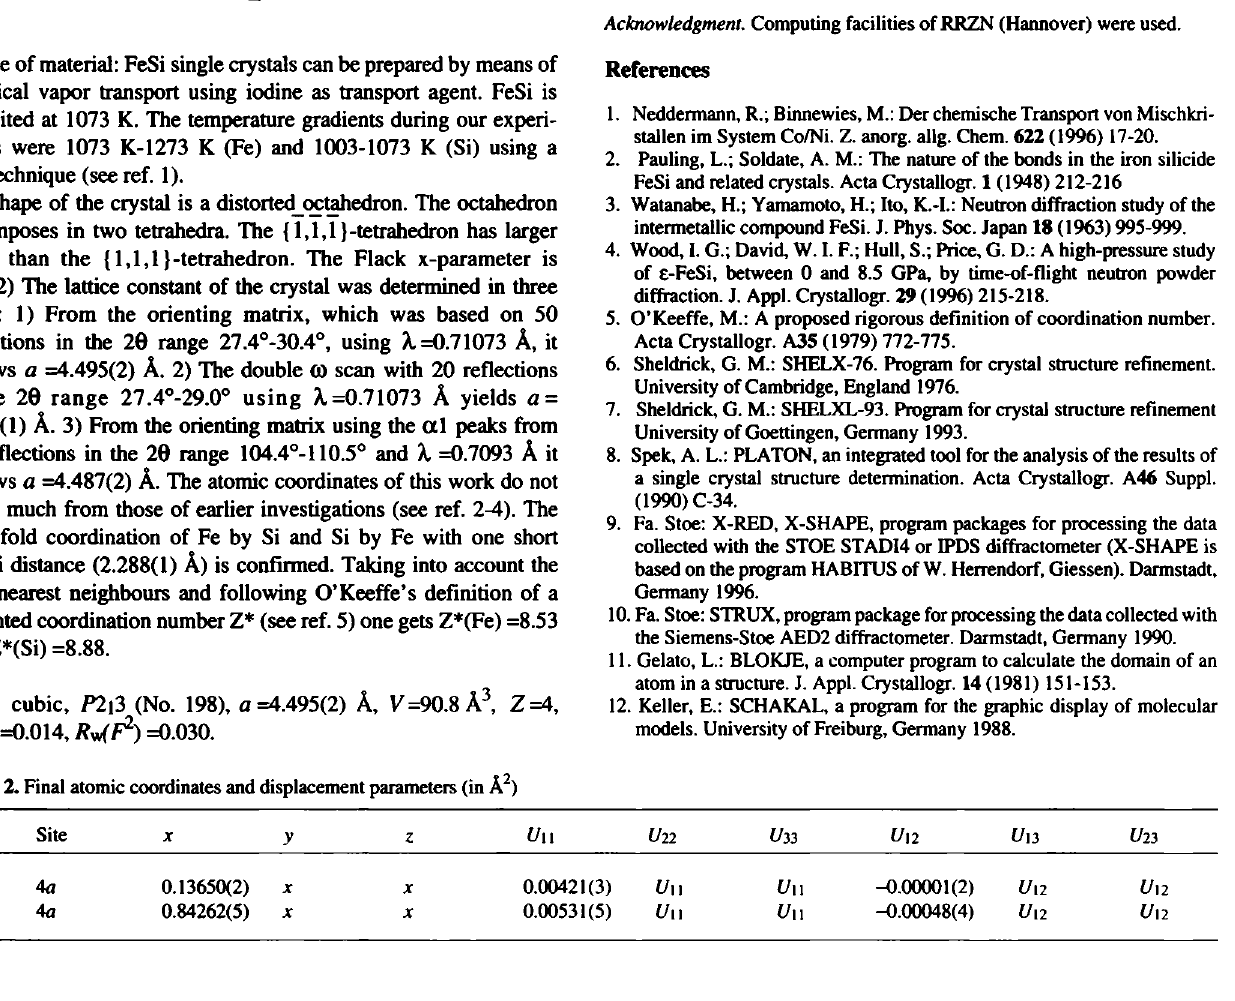
Table 1. Parameters used for the X-ray data collection